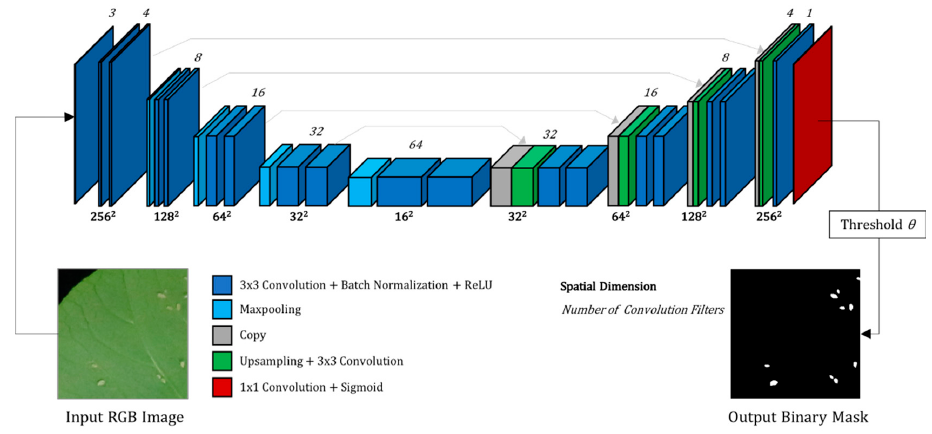
Figure 2. Proposed convolutional neural network (CNN) for segmentation. Different functional blocks are marked in different colors. For each block, its spatial dimension is labeled at the bottom and the number of convolution filters is labeled at the top.